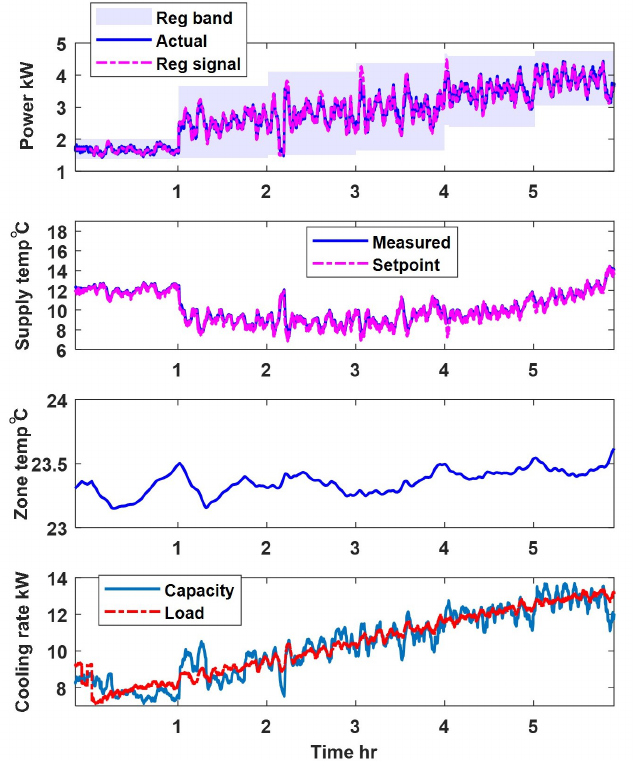
Figure 1. Laboratory test results of frequency regulation for a 5-ton variable-speed rooftop unit.